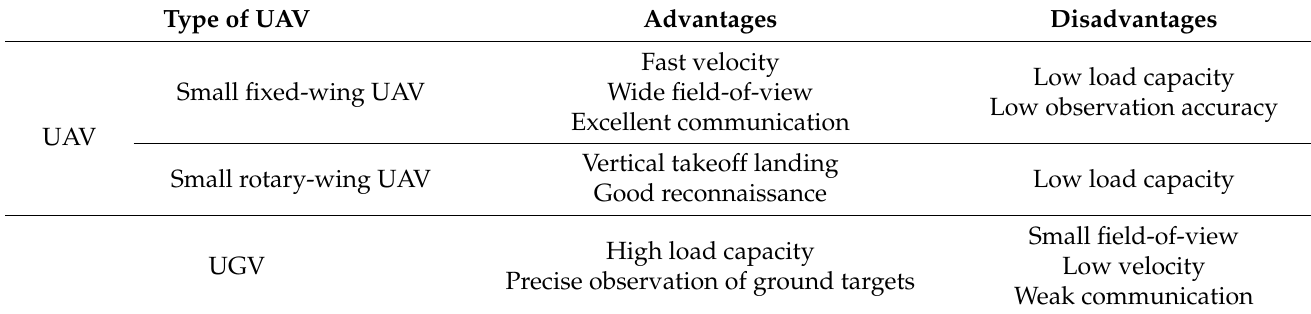
Table 1. Advantages and disadvantages of UAVs and